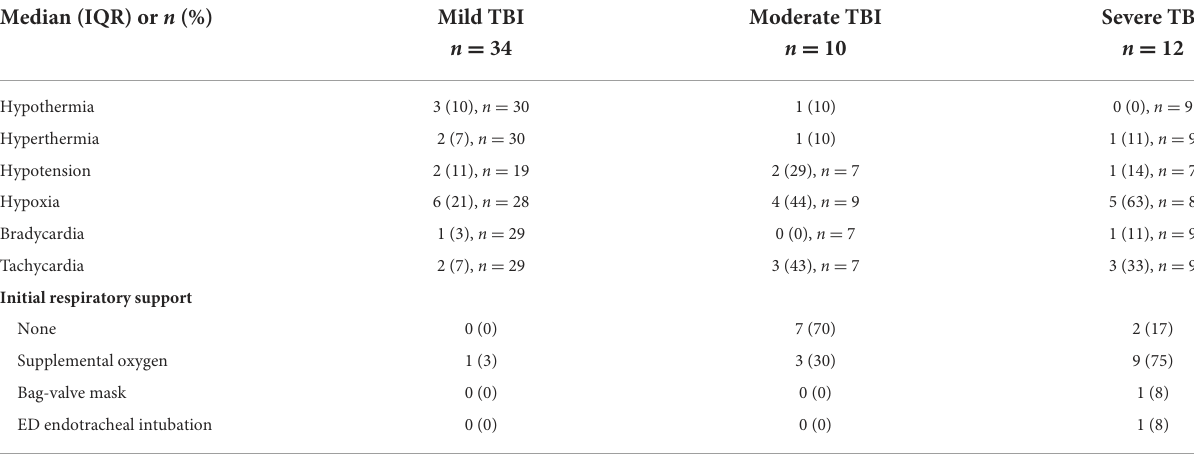
TABLE 2 Initial emergency department physiologic assessment and management by TBI severity.